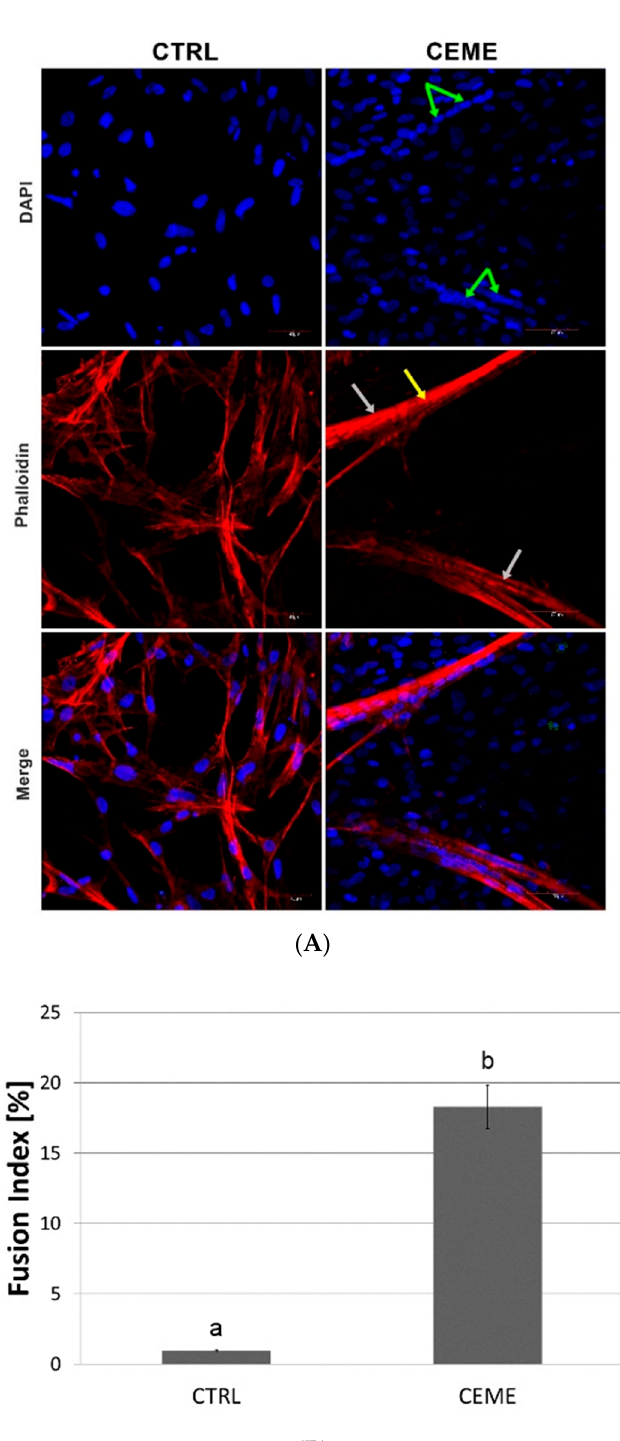
Figure 4. ( A ) Fluorescent images with labeled nuclei (blue) and actin (red) of cells after 5 days of culture: control group (CTRL); culture with chicken embryo muscle extract supplementation (CEME); nuclei in myotubes (green arrows), myotubes (grey arrows), striated sarcomeric structure (yellow arrow); quantitative analysis of the fusion index of the differentiating cells ( B ). The error bars represent standard deviations. Different letters (a, b) above the columns indicate statistically significant differences between the groups ( p ≤ 0.05).